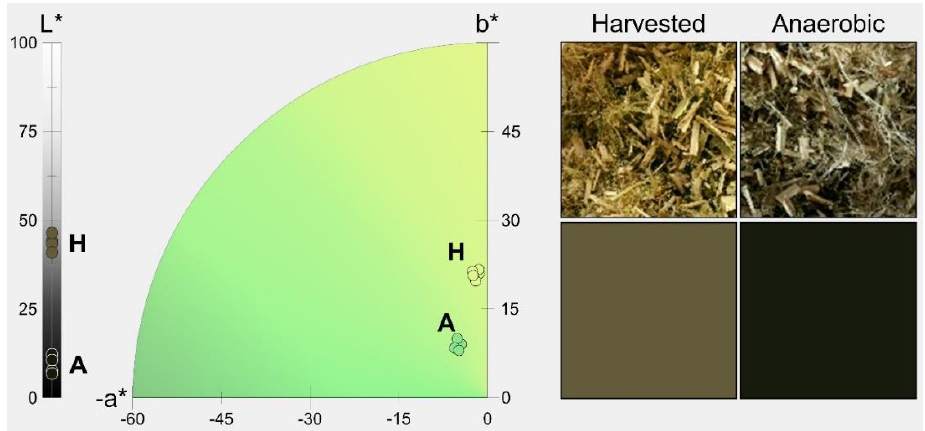
Figure 2. Visual comparison of the two types of hemp (freshly harvested and wet-anaerobic), and their colour representation according to CIELab1976 scheme [109].